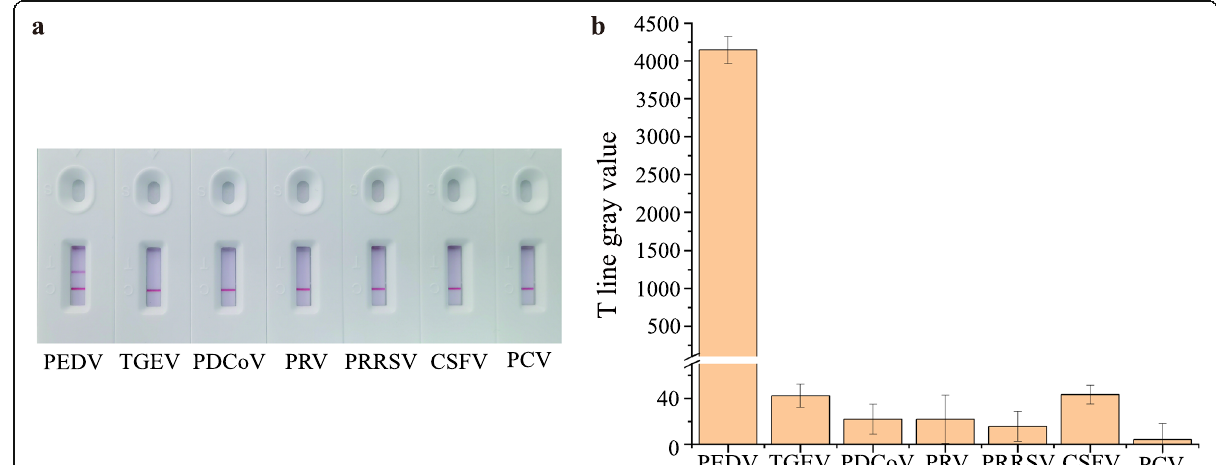
Fig. 5 Analytical specificity. a Photograph of common swine virus tested by LBs-LFIA. b Gray values of T line on the